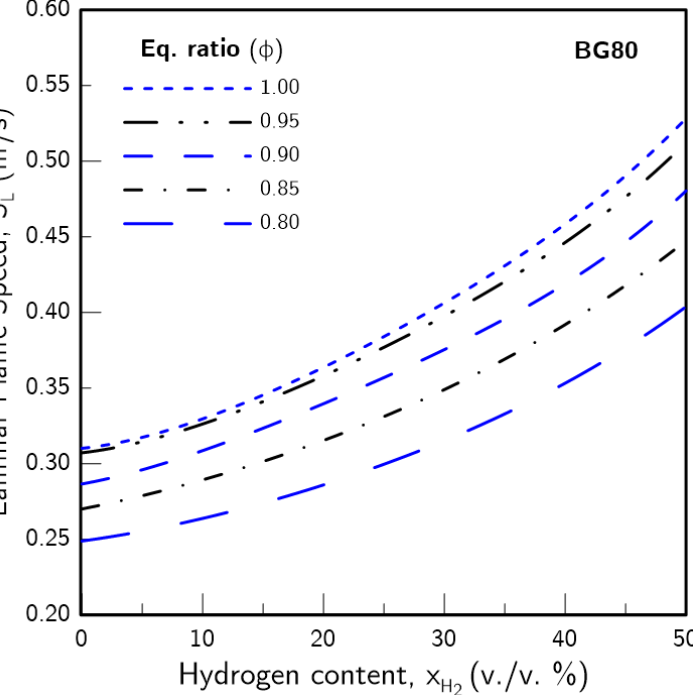
Figure 3. Laminar flame speed of BG80/air flames enriched with H the model results for a determined equivalence ratio ( φ ). Conditions were set at p = 1atm and T u =